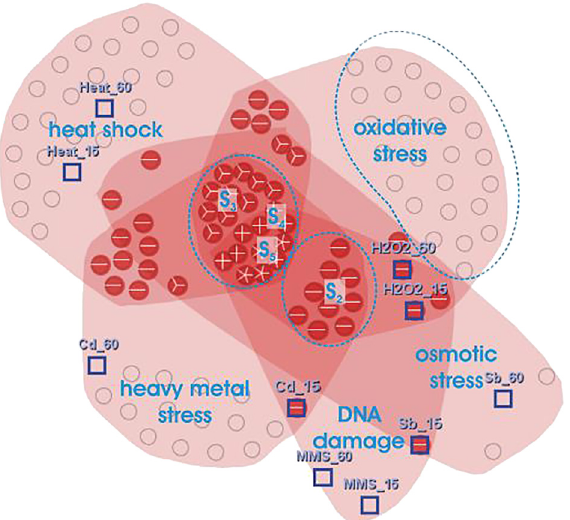
Figure 12: Visualization of five biclusters generated from stress gene expression data. Groups of biclusters and their overlaps can be deducted easily thanks to hulls representation